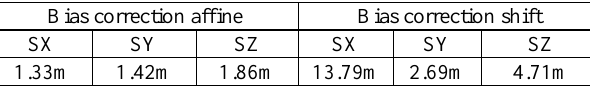
Table 6. 3D-determination of ground control points, Cartosat-1;